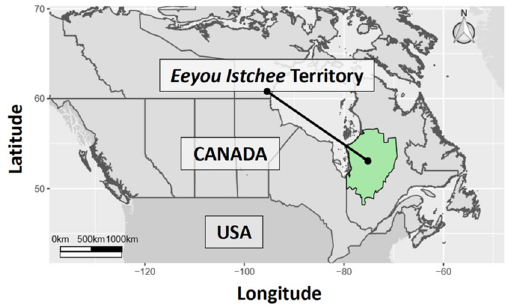
Figure 1. Map of the study region in northern Quebec,